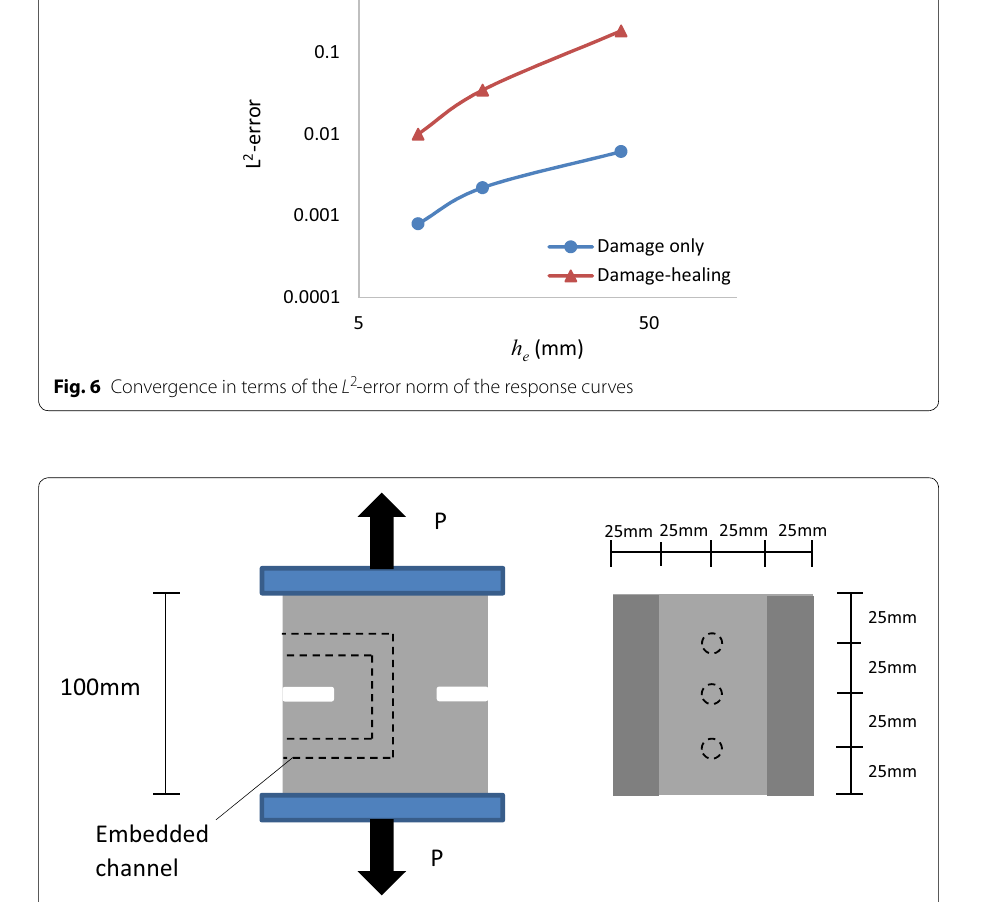
Fig. 7 Schematic of the direct tension test set up the elevation (left) and cross‑section